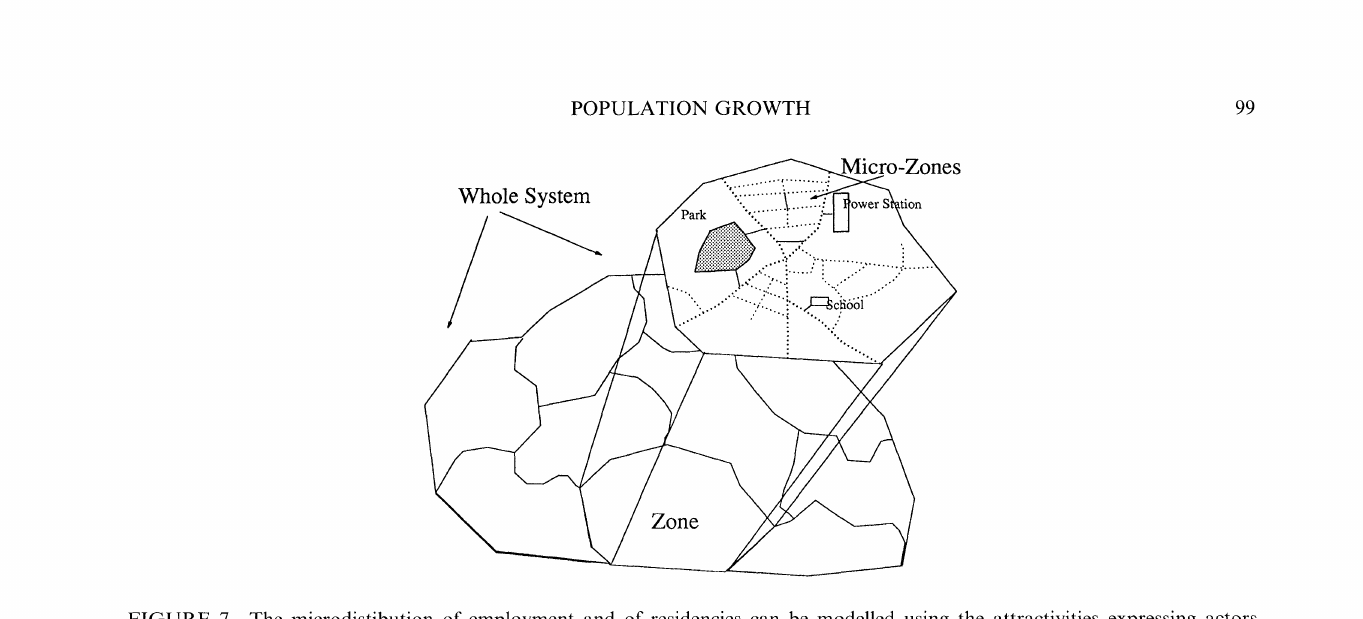
FIGURE 7 The microdistibution of employment and of residencies can be modelled using the attractivities expressing actors preferences, and the very local